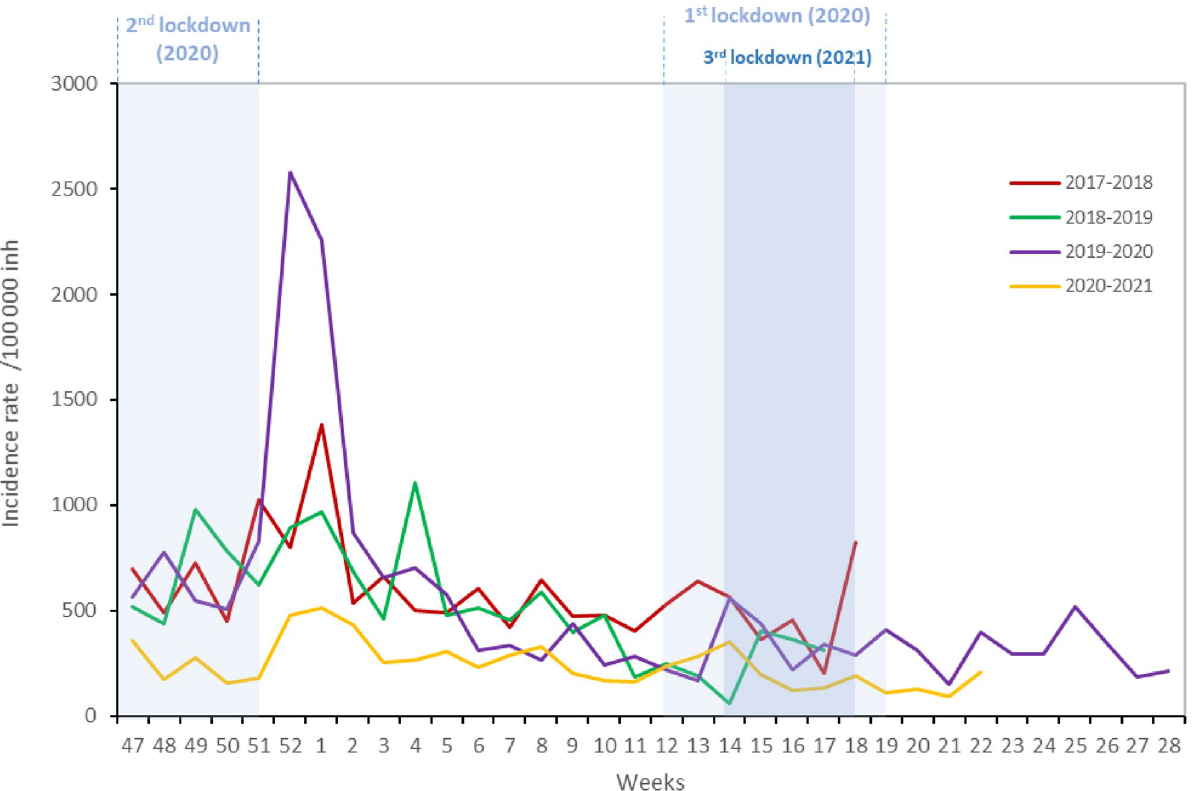
Figure 3. Weekly incidence rates (/100,000 inhabitants) of acute diarrhea from the last 4 winter’ seasons (2017– 2018 to 2020–2021). Red line: from W47-2017 to W18-2018, green line: W47-2018 to W17-2019, purple